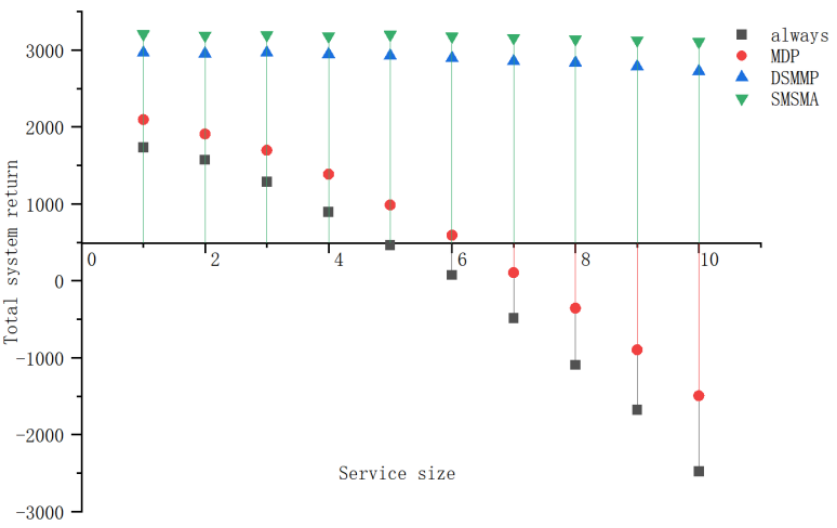
Figure 9. Effect of service size on system total return.